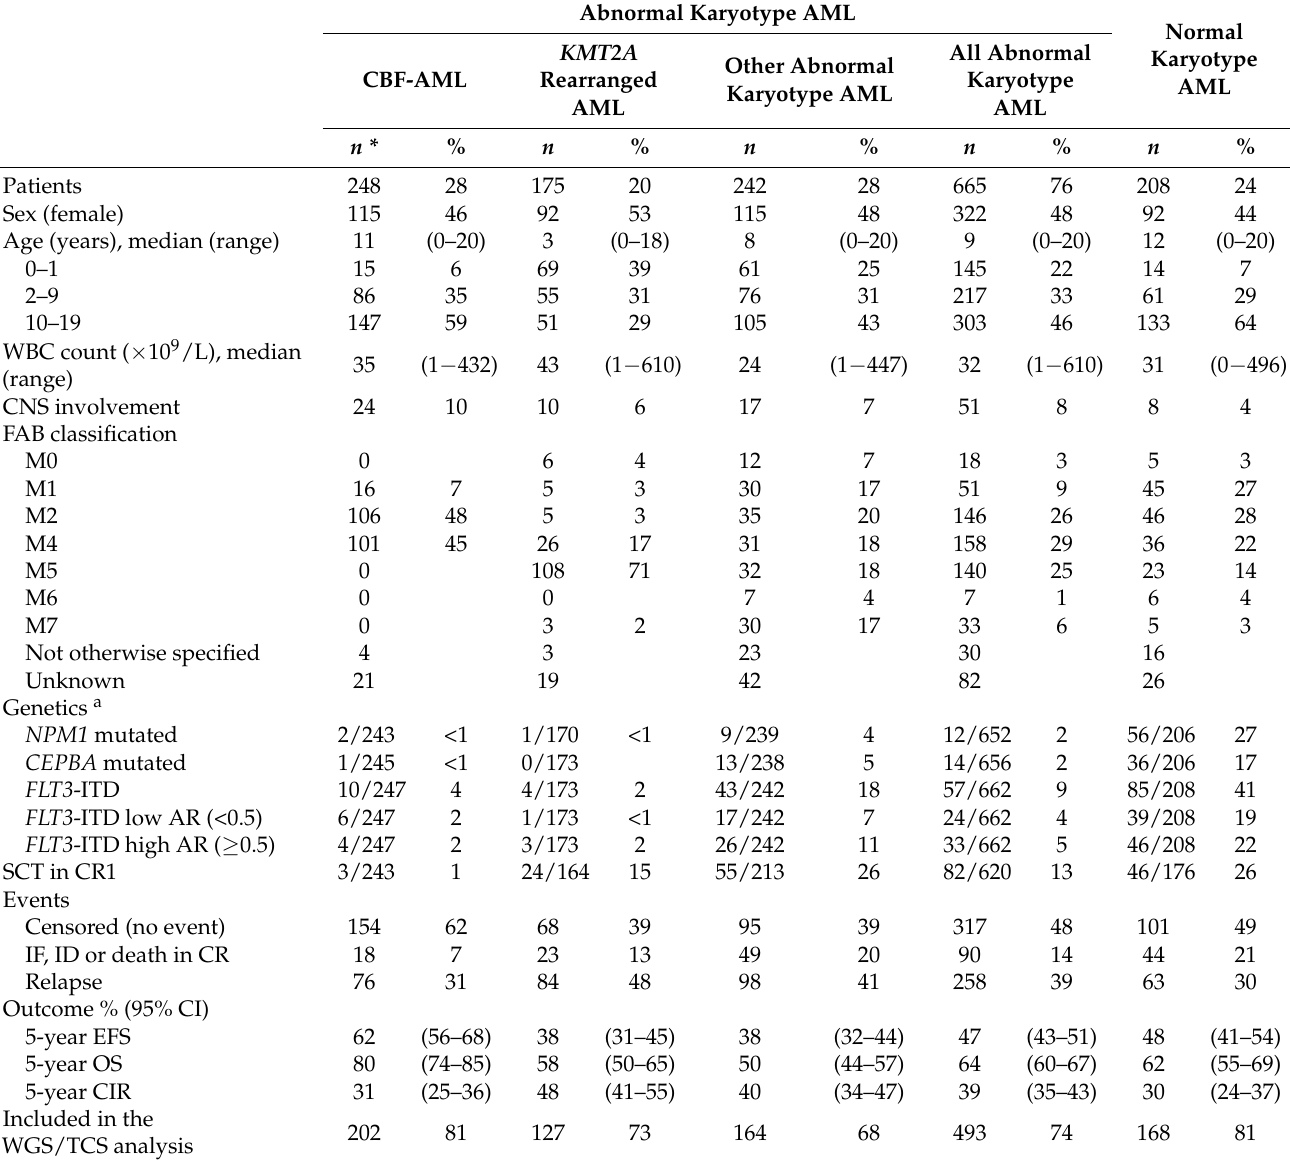
Table 1. Patient characteristics of normal and abnormal karyotype pediatric AML in the TARGET-AML study cohort. Abnormal Karyotype AML